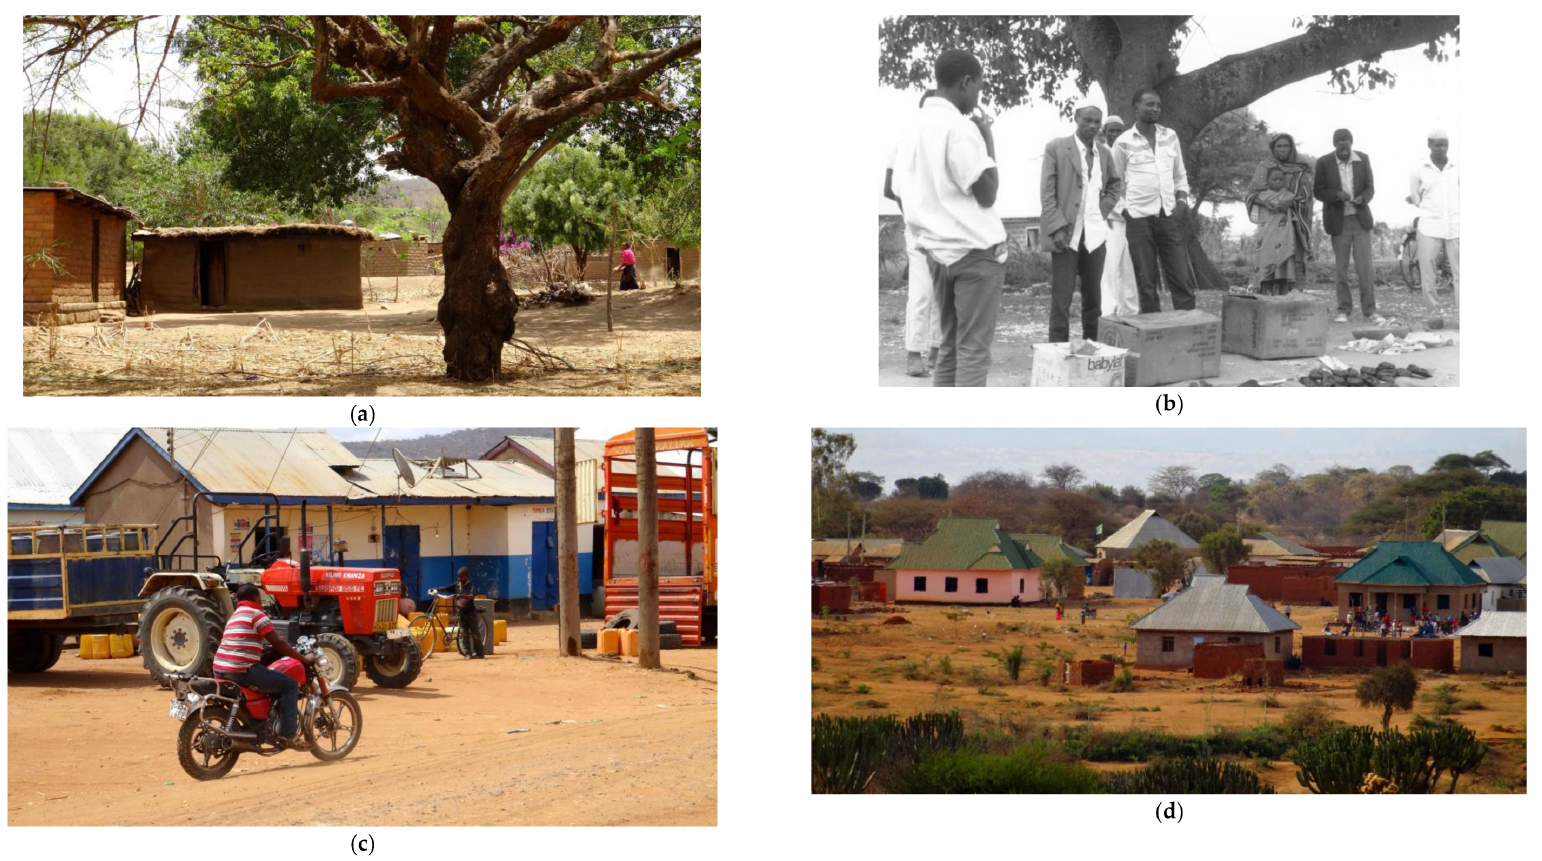
Figure 2. ( a ) Mirambu village centre, 2016. ( b ) Peddlers by the Moogimo tree ( Ficus sp.), Goima village, 1992. ( c ) Busy life at Goima centre, 2016. The Indian manufactured tractor sports the slogan Kilimo Kwanza , meaning ‘Agriculture First’; and, ( d ) Modern houses in Goima